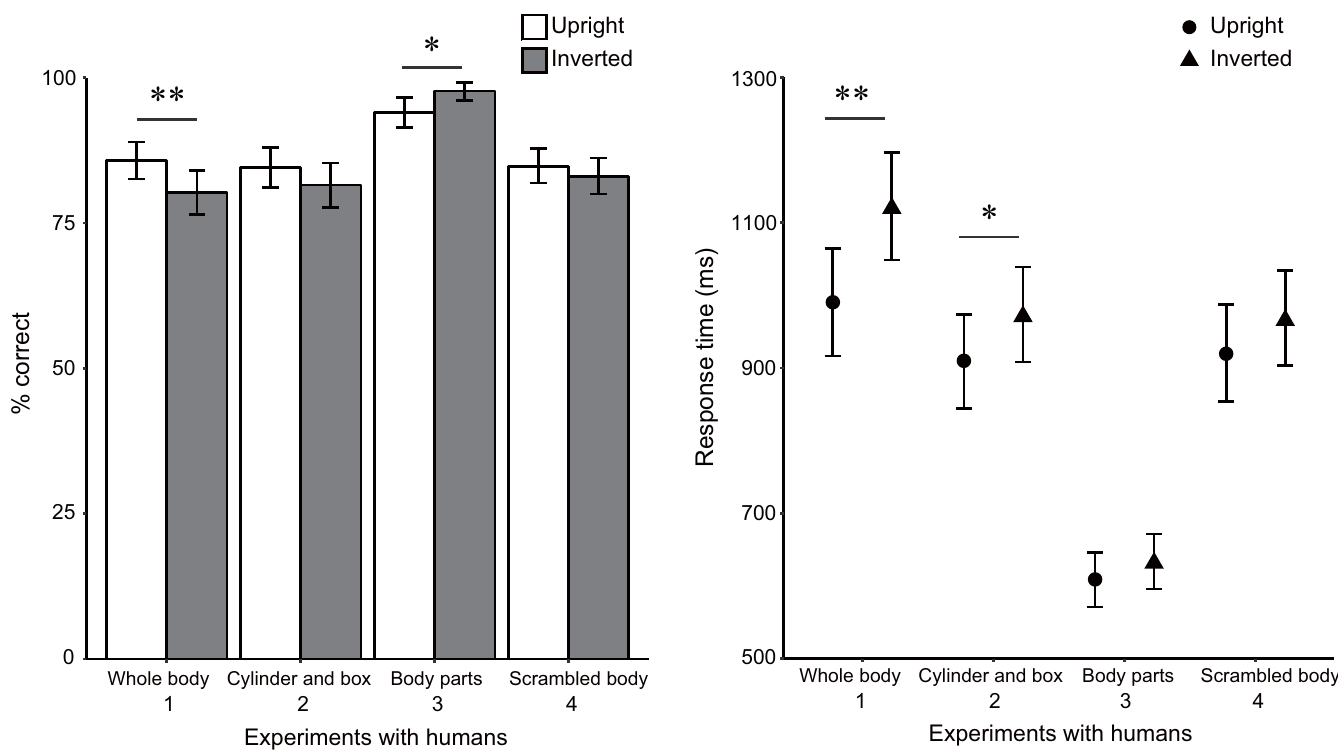
Fig 4. Mean percentages of correct responses and mean response times for correct trials in Experiments with humans. Error bars indicate bootstrapped 95% confidence intervals. (cid:3) p < .05, (cid:3)(cid:3) p < .01.